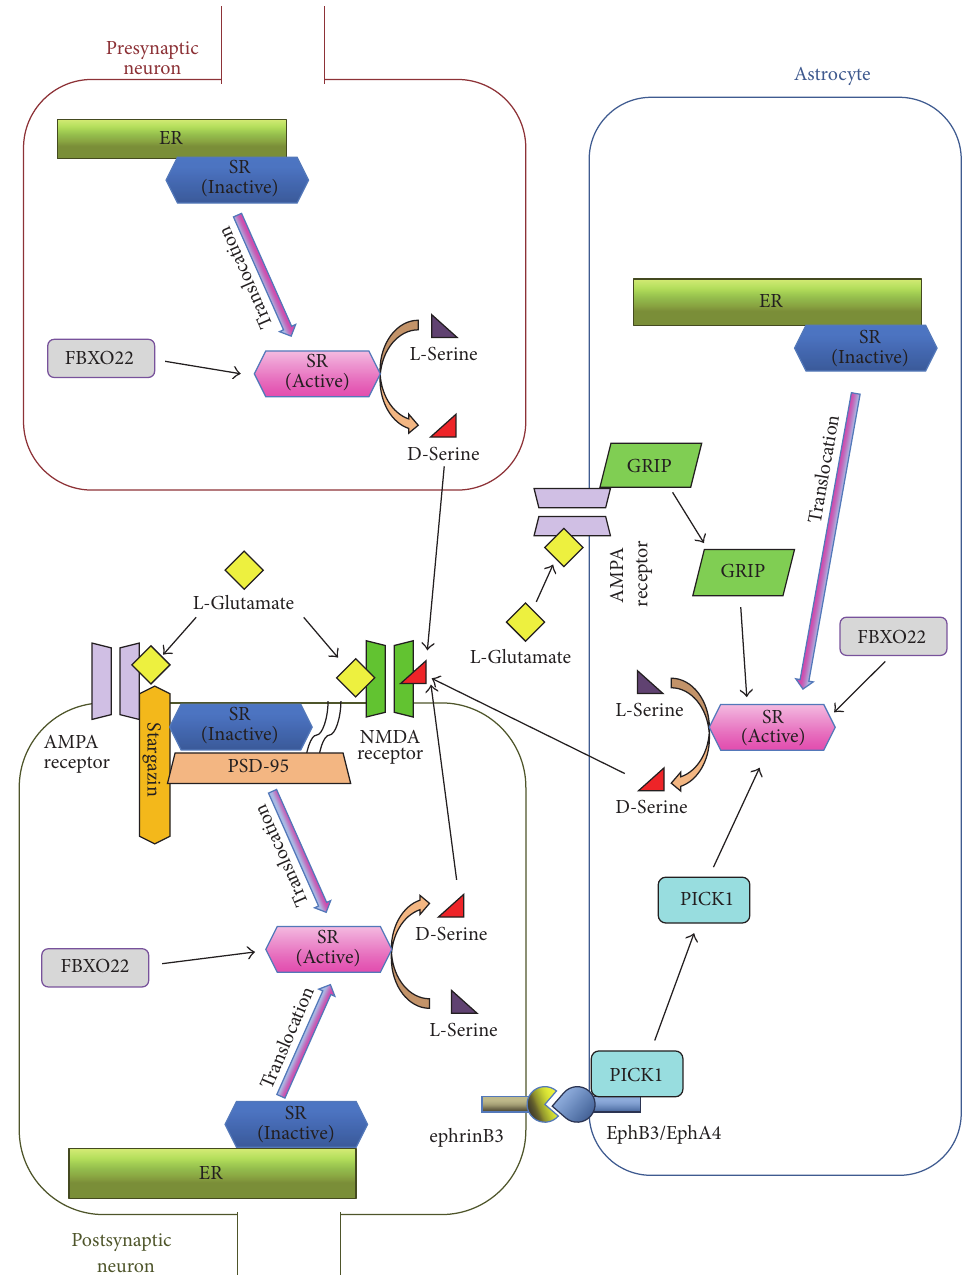
Figure 1: The synthesis of D-serine in the central nervous systems (CNS). D-Serine is synthesized by serine racemase (SR). SR is inhibited by its translocation from the cytosol to a membrane, such as the endoplasmic reticulum (ER) or plasma membranes, all of which contain phosphatidylinositol 4,5-bisphosphate (PIP 2 ). F-box only protein 22 (FBXO22) interacts with SR and activates SR by preventing it from binding to the ER membrane. In astrocytes, glutamate receptor interacting protein 1 (GRIP1) binds to the 𝛼 -amino-3-hydroxy-5- methylisoxazole-4-propionic acid (AMPA) receptor and GRIP1 is then released from the AMPA receptor following stimulation with L- glutamate. Released GRIP1 activates SR. Protein interacting with C-kinase (PICK1) binds to erythropoietin-producing hepatocellular receptor (Eph)B3 or EphA4 in the astrocytes. PICK1 is released after ephrinB3 on the neurons interacts with the EphB3 or EphA4 receptor and then activates SR. Stargazin forms a complex with the AMPA receptor, postsynaptic density protein 95 (PSD-95), and SR and inhibits the activity of SR by promoting membrane localization in neurons. After the AMPA receptor is activated, SR is released from the plasma membrane, resulting in the activation of SR. The N-methyl-D-aspartate (NMDA) receptor is activated by glutamate and